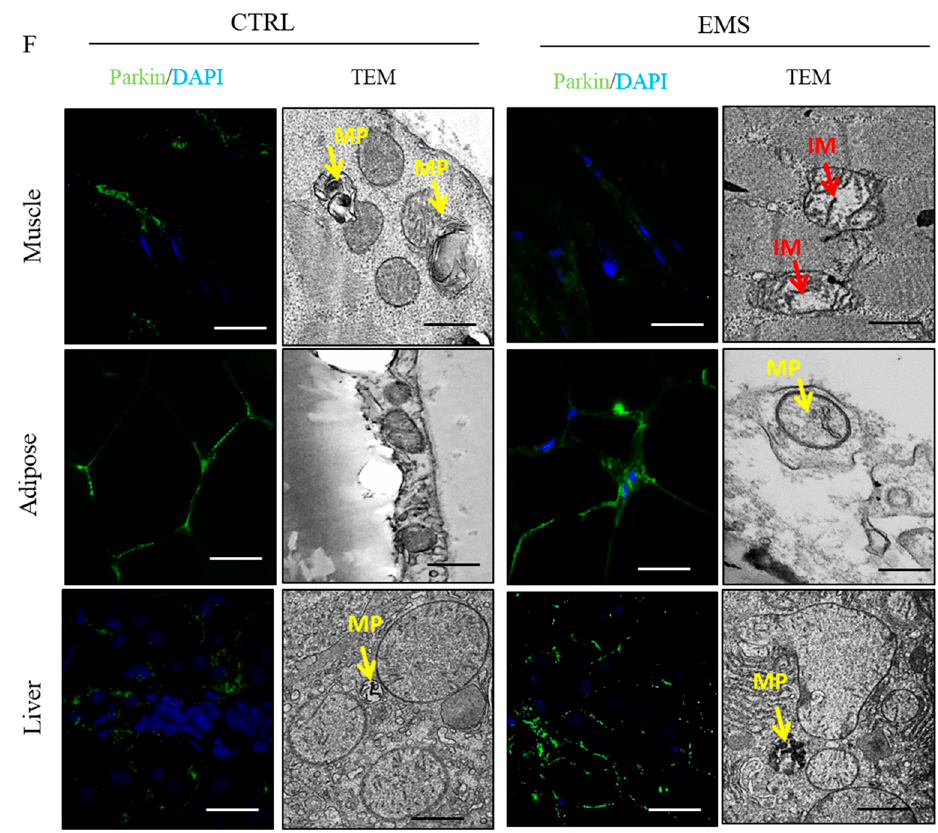
Figure 6. Evaluation of mitophagy and mitochondrial dynamics in tissues from healthy and EMS-diagnosed horses. Using RT-PCR, the expression of PINK ( A ), PARKIN ( B ), MNF ( C ) and FIS ( D ) was investigated. PARKIN amount was also examined by Western blot ( E ) and immunofluorescence staining ( F ). TEM imaging ( F ) allowed for visualization of mitophagosomes’ formation (indicated with yellow arrows) and mitochondria morphology impairment (indicated with red arrows). MP, mitophagosomes; IM, impaired mitochondria. Results expressed as the mean ± S.D. ** p < 0.01, *** p < 0.001. Scale bars: confocal 20 µm, TEM 100 nm.